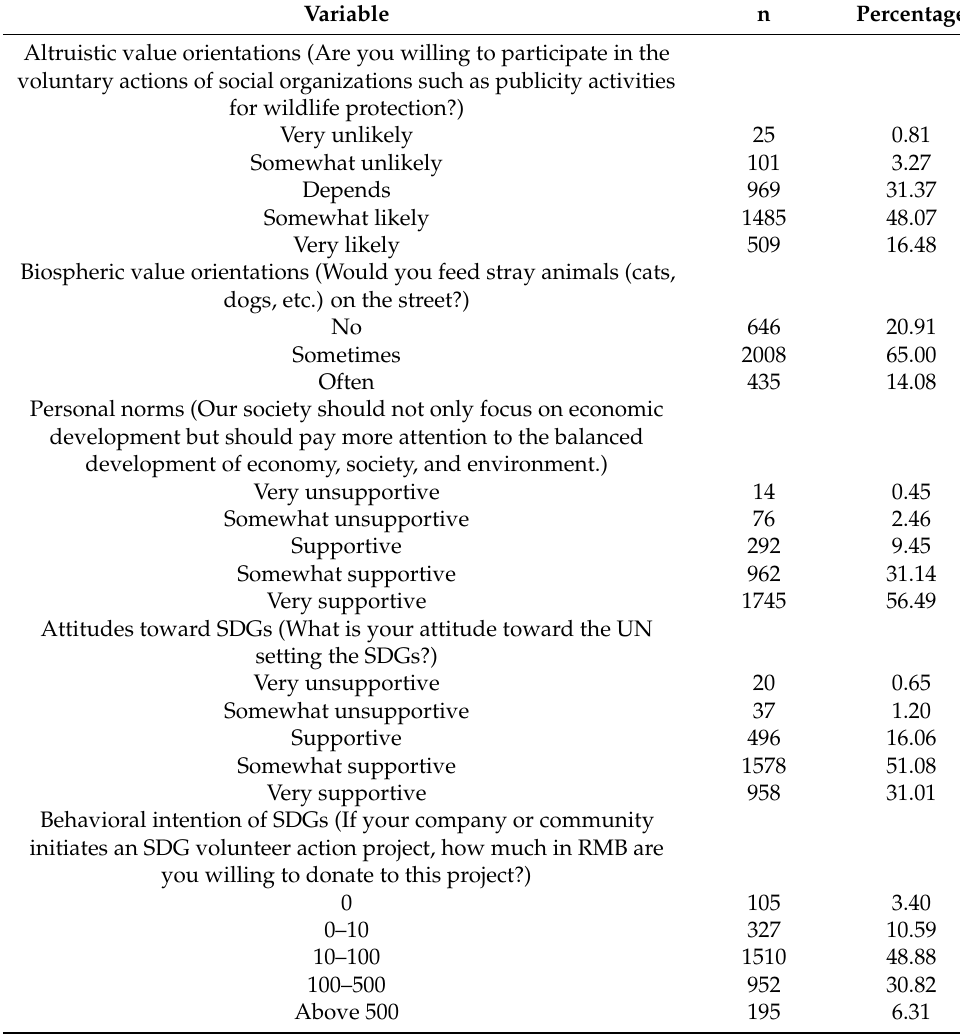
Table 2. Measurement of instruments (n = 3089). Variable n